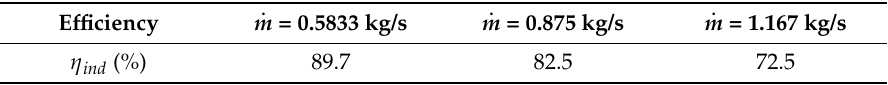
Table 3. Efficiency system for the first configuration varying the liquid flow rate.